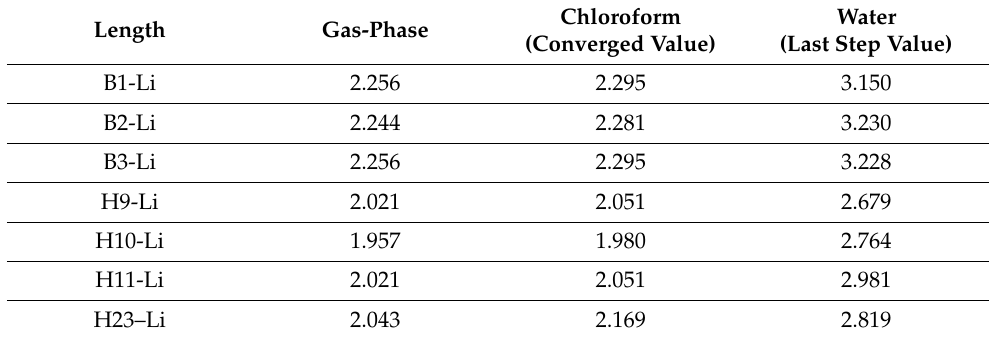
Table 1. MP2/(Li-aug)-cc-pVDZ results for bond lengths (Å) of the C s conformer in the gas phase and solution. In the case of chloroform, the values are convergent within an error bar of 0.001 Å. Length Gas-Phase